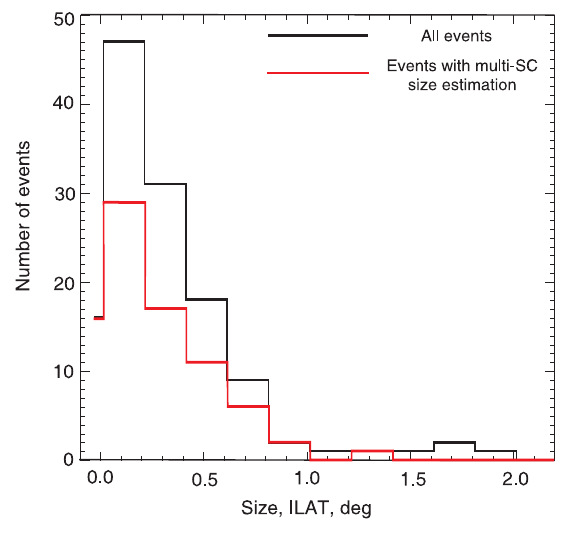
Fig. 7. Histograms showing the distribution of sizes of the electron edge of the LLBL, for all events (black line) and for events in which we obtained a multi-spacecraft estimation of the size (red